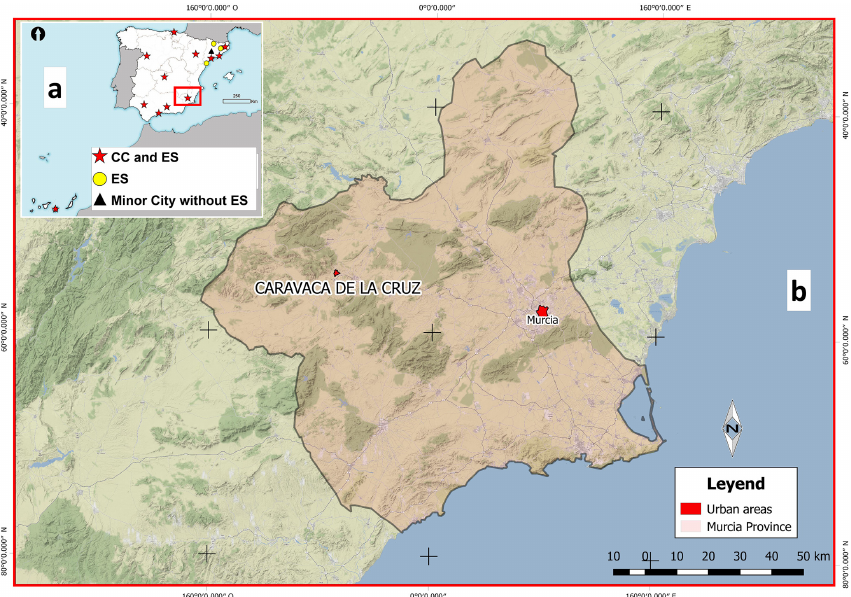
Figure 1. Location maps of reconstructed series with an instrumental overlap in Spain (a) and the study area (Caravaca de la Cruz) (a) . Panel (a) shows the reconstructed series in Spain that overlap instrumental records. Red stars identify the reconstructed series in capi- tal cities (CCs) that are also episcopal sees (ESs). The yellow circle identifies the reconstructed series in cities that are ESs. Finally, the black triangle identifies the small cities with no capital or episcopal see. Panel (b) represents the location of the study area (Caravaca de la Cruz). Sources: Martín-Vide and Barriendos (1995), Sánchez-Rodrigo et al. (1999), García-Herrera et al. (2003), Vicente-Serrano and Cuadrat (2007), Sánchez-Rodrigo and Barriendos (2008) and Gil-Guirado